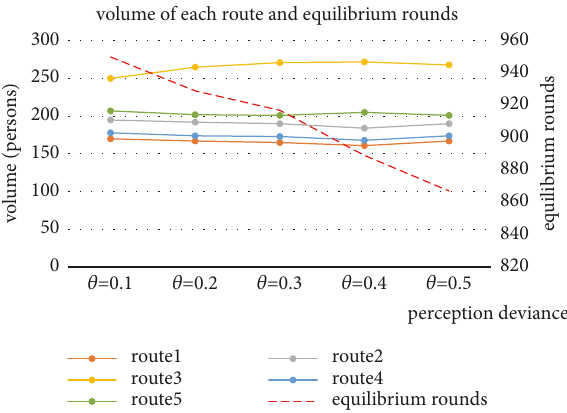
Figure 7: Volume evolution of five routes for 𝑞 = 1000 , 𝛼 = 0.3 , Δ = 0.2 .